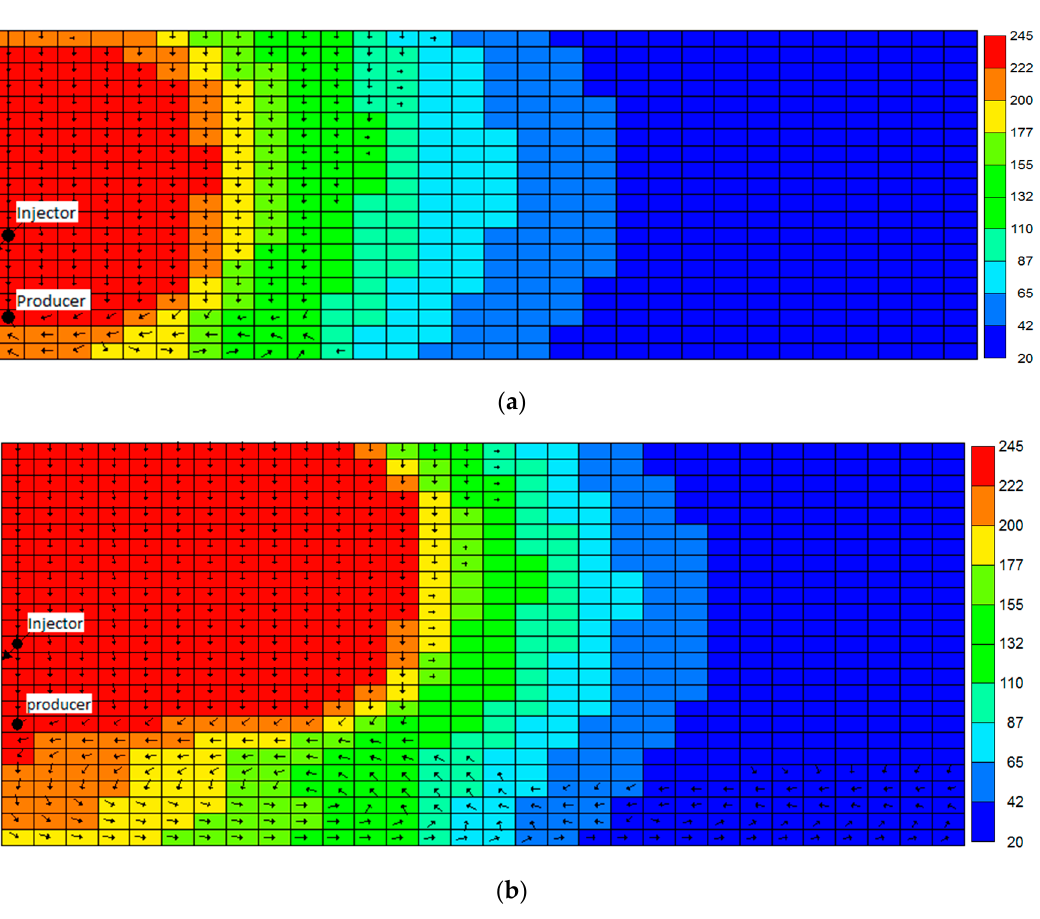
Figure 9. Temperature distribution and water flow direction in the reservoir after 5 years of production: ( a ) reservoir without a bottom water zone and ( b ) reservoir with a 5-m bottom water zone.